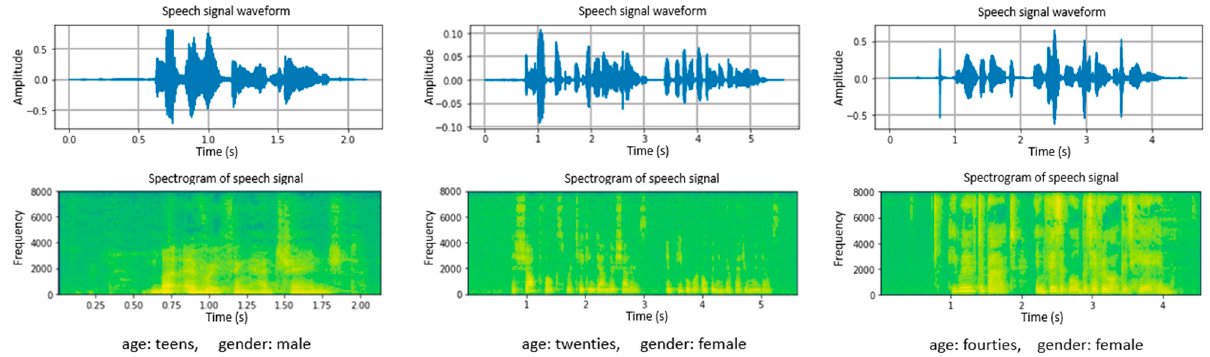
Figure 2. Audio waveforms and corresponding spectrograms of speech samples.